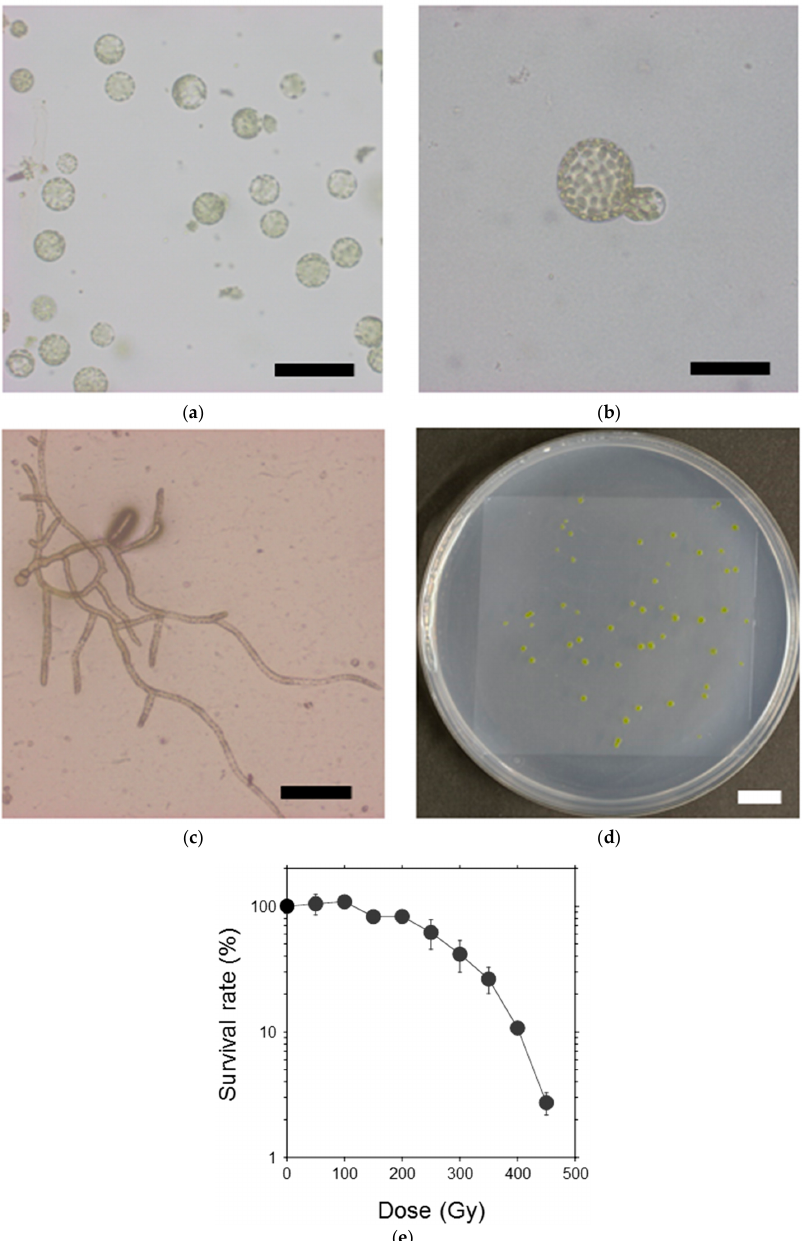
Figure 3. Reduction in survival rate of P. patens protoplasts after γ -irradiation. Representative images of ( a ) isolated protoplasts, ( b ) asymmetric first cell division, ( c ) a proliferating colony, and ( d ) visible colonies are shown. Bars indicate 100 μ m, 50 μ m, 200 μ m, and 10 mm in length in ( a – d ), respectively. ( e ) Survival rate of protoplasts plotted as a function of γ -ray dose. The data are the mean ± SEM of three or more independent experiments. The survival rate decreased with increasing γ -ray dose. The dose that decreased the survival rate by 50% (LD 50 ) was 277